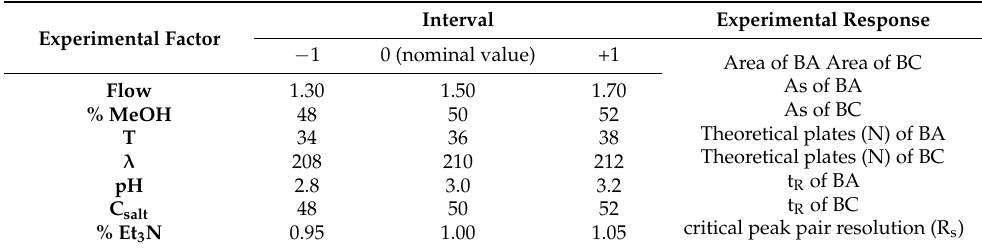
Table 1. Experimental factors under evaluation, regarding their effect on specific responses.